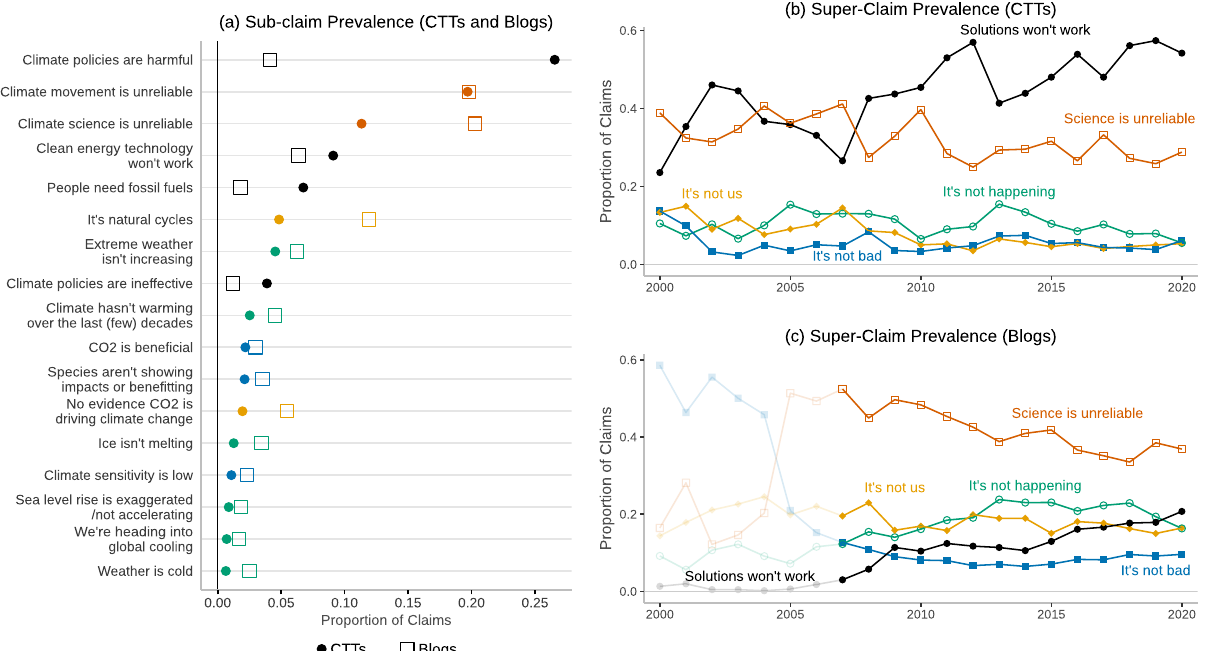
Figure 2. Prevalence of super- and sub-claims by CTTs and contrarian blogs. ( a ) illustrates the share of claim- making paragraphs related to the sub-claims of our taxonomy by CTTs (circle) and blogs (hollow square). ( b ) and ( c ) Display the share of 515,005 claim-making paragraphs devoted to the following super-claim categories: 1. Global warming is not happening (green hollow circle), 2. Humans are not causing global warming (yellow diamond), 3. Climate impacts are not bad (blue filled square), 4. Climate solutions won’t work (black circle), and 5. Climate movement/science is unreliable (orange hollow square). Note that estimates prior to 2007 in ( c ) are derived from a relatively small number of